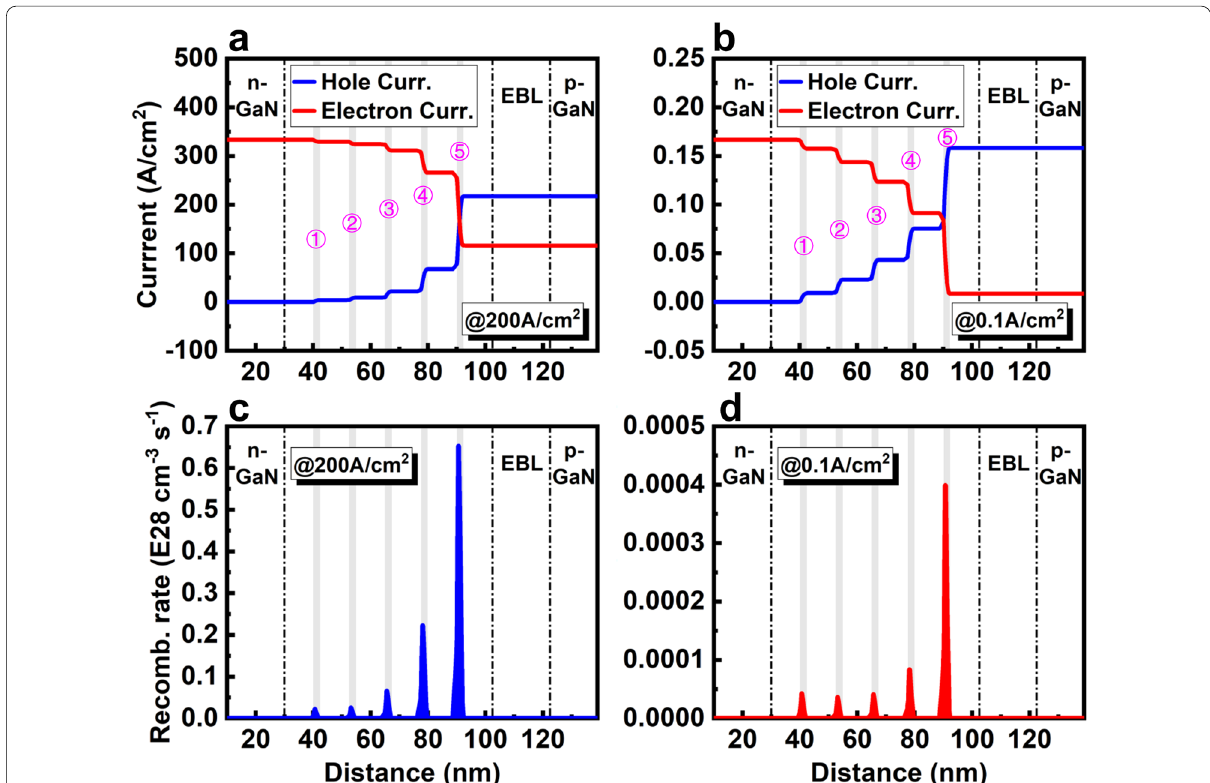
Fig. 3 Carrier current distribution of LED with 5QWs a at 200 A/cm 2 and b at 0.1 A/cm 2 . Radiative recombination rates of LED with 5QWs c at 200 A/ cm 2 and d at 0.1 A/cm